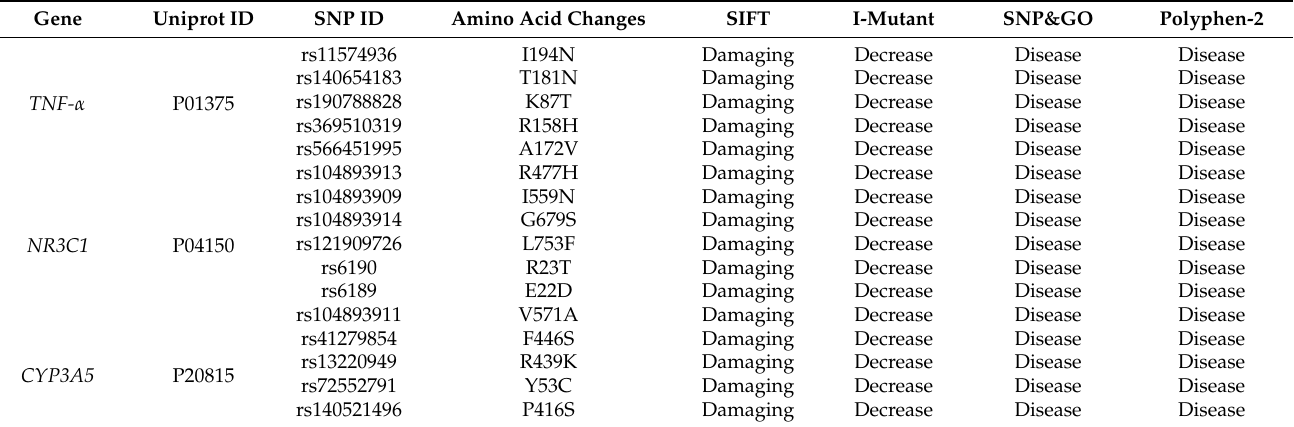
Table 1. Prediction of the effect of SNPs by using SIFT, I-Mutant, SNP&GO, and PolyPhen-2 server.